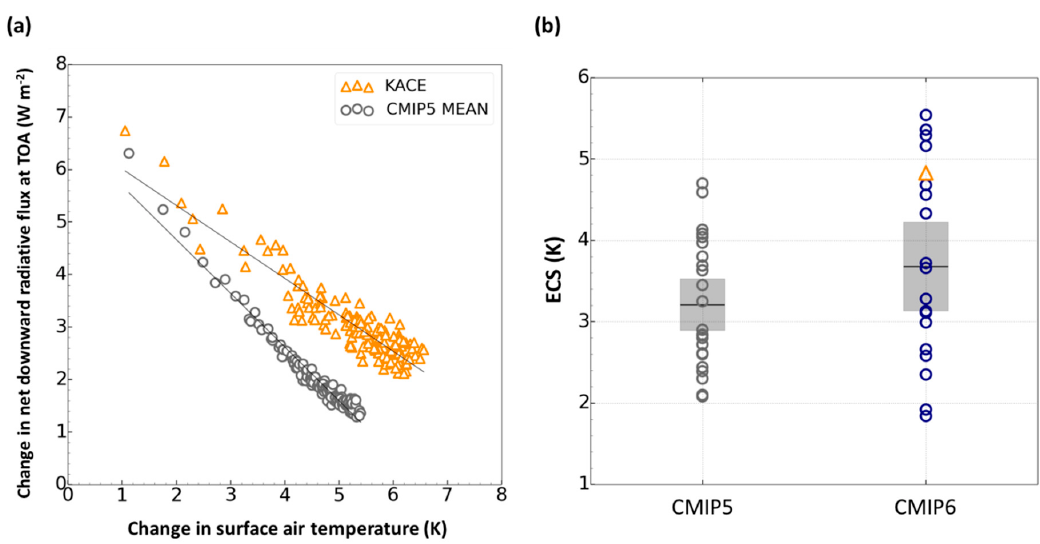
Figure 2. ( a ) Gregory plot [48] used to estimate the equilibrium climate sensitivity (ECS) of K-ACE (orange triangles) and CMIP5 ensemble experiment (gray circles). ( b ) Range of ECS from CMIP5 and CMIP6 models. Gray box indicates 5–95% confidence range of each group; gray and blue circles indicate each model and orange triangle indicates K-ACE.